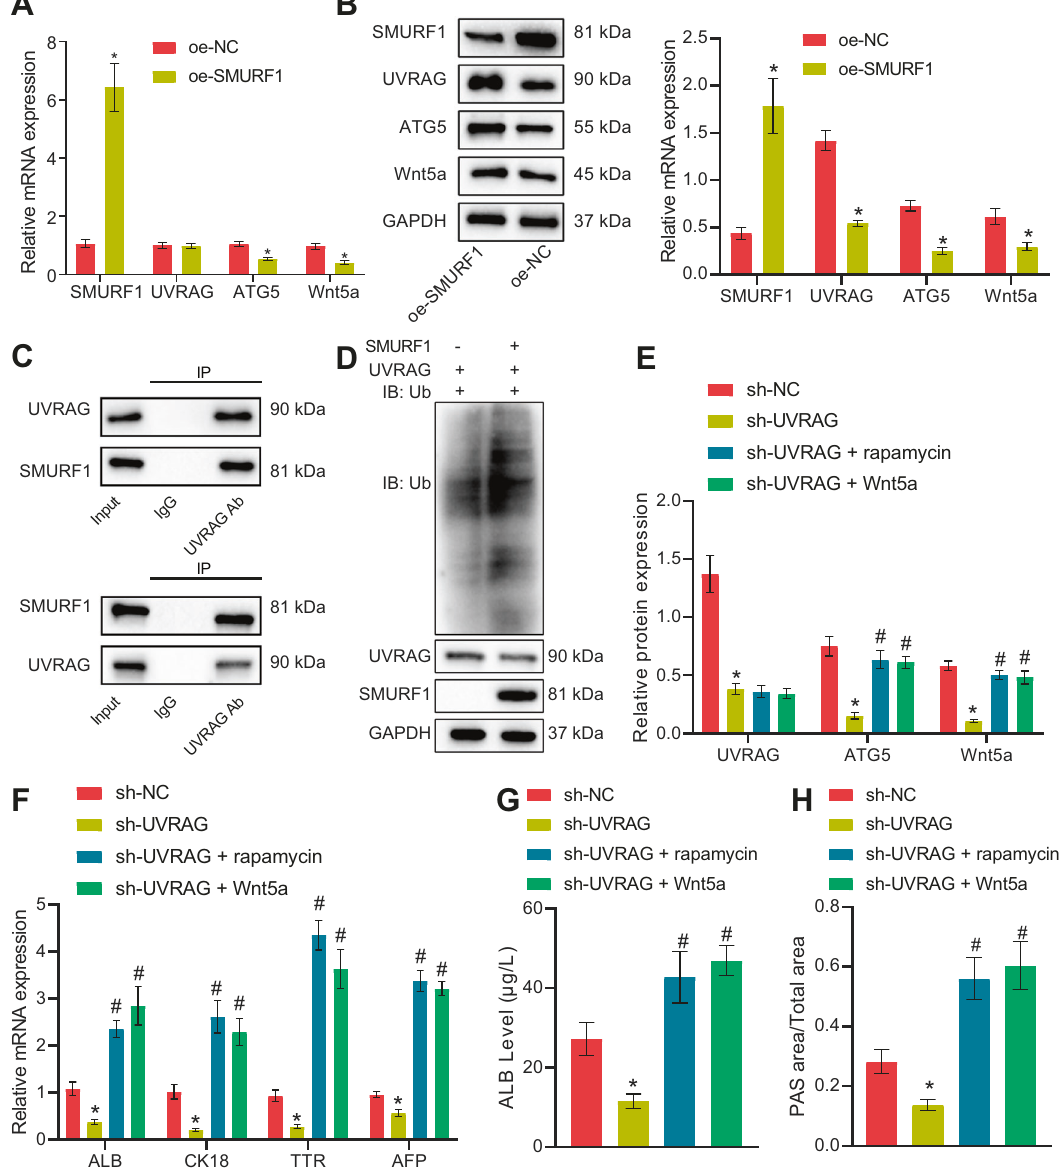
Fig. 8 SMURF1 promotes ubiquitination of UVRAG and regulates ATG5/Wnt5a to suppress HLC differentiation of mouse BMSCs. A RT- qPCR to determine the expression of UVRAG, ATG5, and Wnt5a after overexpressing SMURF1. B The expression of UVRAG, ATG5, and Wnt5a after overexpression of SMURF1 detected by Western blot analysis. C The binding between SMURF1 and UVRAG assessed by Co-IP analysis. D The effect of SMURF1 on the ubiquitination of UVRAG measured by Co-IP analysis. E The effect of concomitant treatment of rapamycin or recombinant Wnt5a and sh-UVRAG on the expression of ATG5, Wnt5a assessed by Western blot analysis. F RT-qPCR to determine the expression of hepatocyte-related genes in BMSCs after 14 days of simultaneous treatment of rapamycin or recombinant Wnt5a and sh-UVRAG. G ELISA assay to detect the ALB content in culture supernatant of BMSCs after 14 days of concomitant treatment of rapamycin or recombinant Wnt5a and sh-UVRAG. H PAS staining to detect the accumulation of glycogen in BMSCs after 14 days of simultaneous treatment of rapamycin or recombinant Wnt5a and sh-UVRAG. * p < 0.05 vs . BMSCs transfected with oe-NC/sh-NC; # p < 0.05 vs . BMSCs transfected with sh-UVRAG. The cell experiments were repeated three times. Identi fi cation of BMSCs immunophenotype by fl ow cytometry Immuno fl uorescence staining Flow cytometry was performed to detect the expression of BMSC surface BMSCs were seeded in 24-well plates, and the BMSC marker CD105 and antigen markers o CD105 (an MSC marker), CD34 (to exclude primary hepatocyte markers AFP and ALB were analyzed with immuno fl uores- hematopoietic and endothelial cells), and CD45 (to exclude leukocytes). cence staining. Brie fl y, cells were fi xed with 4% PFA for 30 min, washed, BMSCs were trypsinized and incubated with the following antibodies for and blocked with 1% BSA for 30 min, followed by incubation with 30 min: anti-CD105 (MCA1557F; Bio-Rad, Hercules, CA, USA), anti-CD34 primary antibodies against CD105 (ab221675, 1:2000, Abcam, UK), ALB (MBS438077; MyBioSource, San Diego, CA, USA), and anti-CD45 (ab10558; (ab222923, 1:2000, Abcam) and AFP (ab213328, 1:2000, Abcam) Abcam). A FAC Scan fl ow cytometer (Becton Dickinson, Heidelberg, overnight. Afterward, the cells were incubated with fl uorescence- Germany) was employed, and fl ow cytometric data were analyzed with the conjugated secondary antibodies for 2 h and subsequently with DAPI FlowJo software (Tree Star Inc., Ashland, OR, USA). (OriGene Technologies, Rockville, MD, USA) for 20 min. Stained Cell Death Discovery (2022)